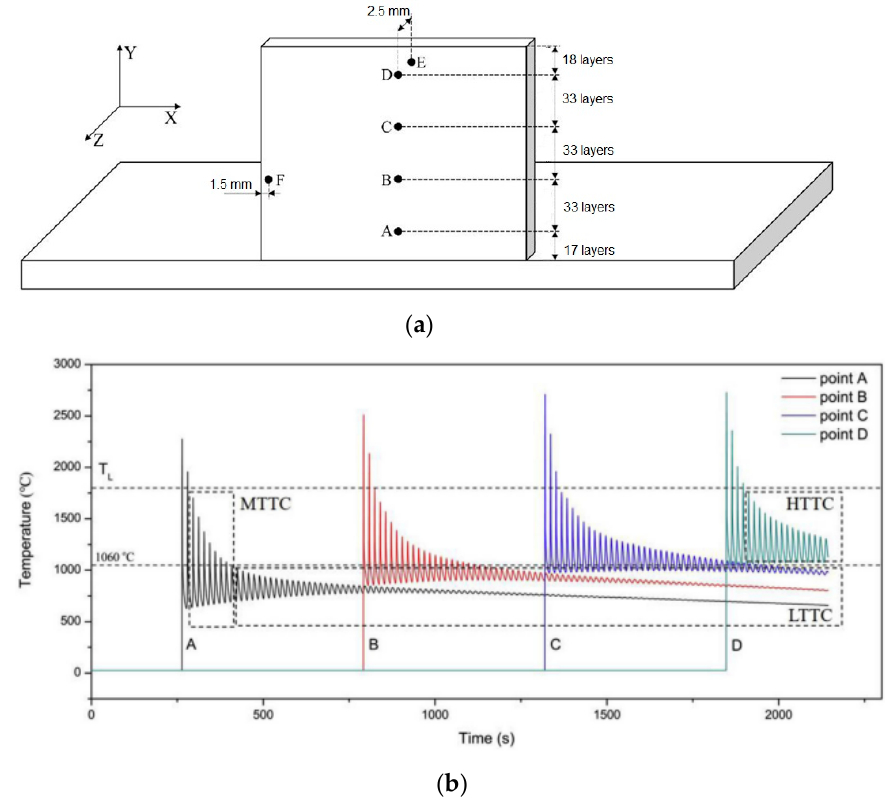
Figure 9. Thermal history in different points through the height of the sample produced by L-DED ( a ) used to simulate the time-temperature ( b ). Reproduced with permission from Elsevier [10].